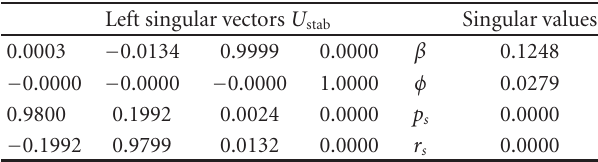
Table 2: SVD of lateral control distribution matrix a